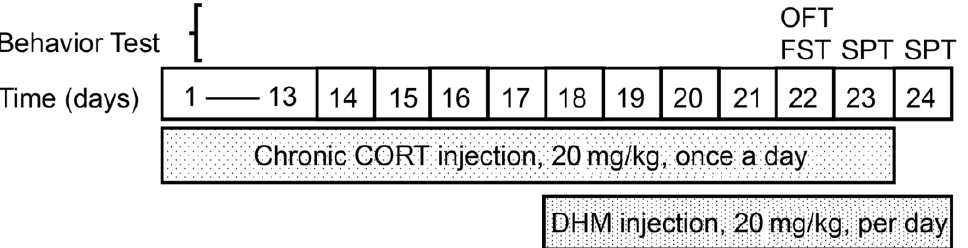
Figure 1. Schematic of the experimental design showing the timeline of drug injection and behavior tasks. CORT, corticosterone; DHM, dihydromyricetin; OFT, open field test; FST, forced swimming test; SPT, sucrose preference test.